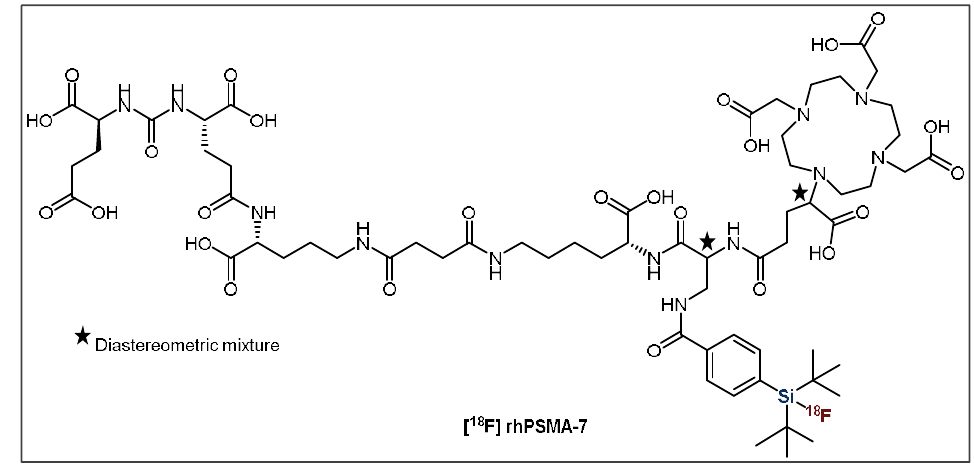
Figure 10. General structure of [ 18